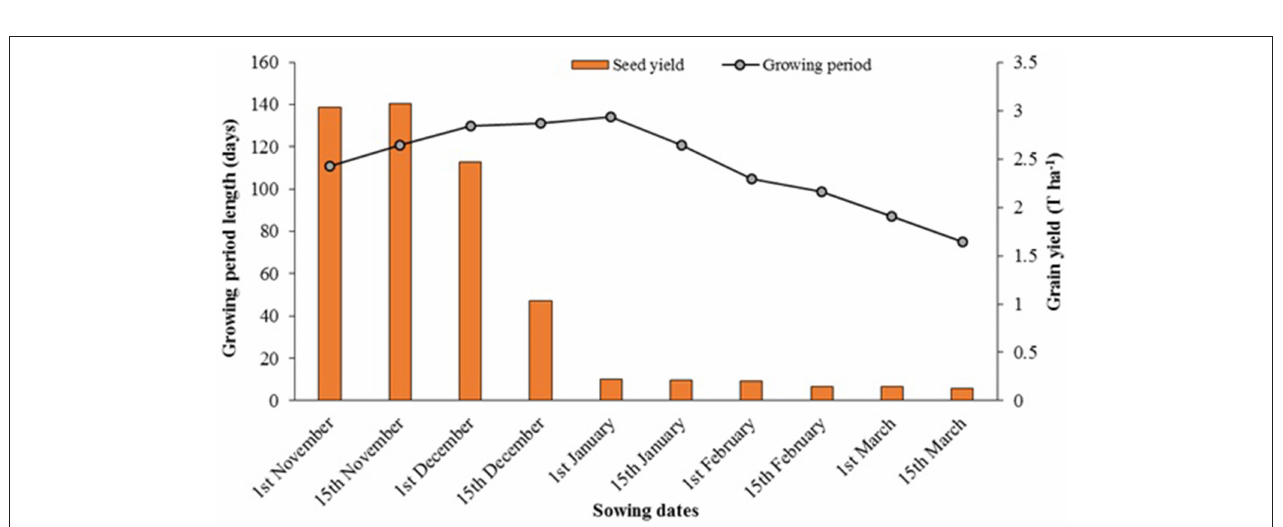
FIGURE 8 | Effect of sowing dates on quinoa yield and growing period length (Hirich et al.,